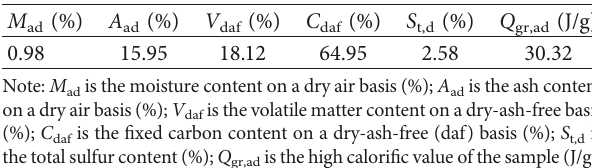
Figure 1: Schematic diagram of the experimental platform for the high-low temperature coal gas desorption and adsorption experiments. Table 1: Proximate analysis of the coal